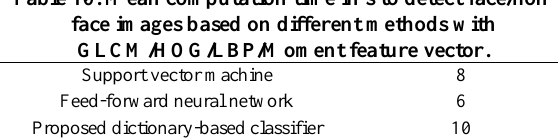
Table 10. Mean computation time in s to detect face/non- face images based on different methods with GLCM/HOG/LBP/Moment feature vector.